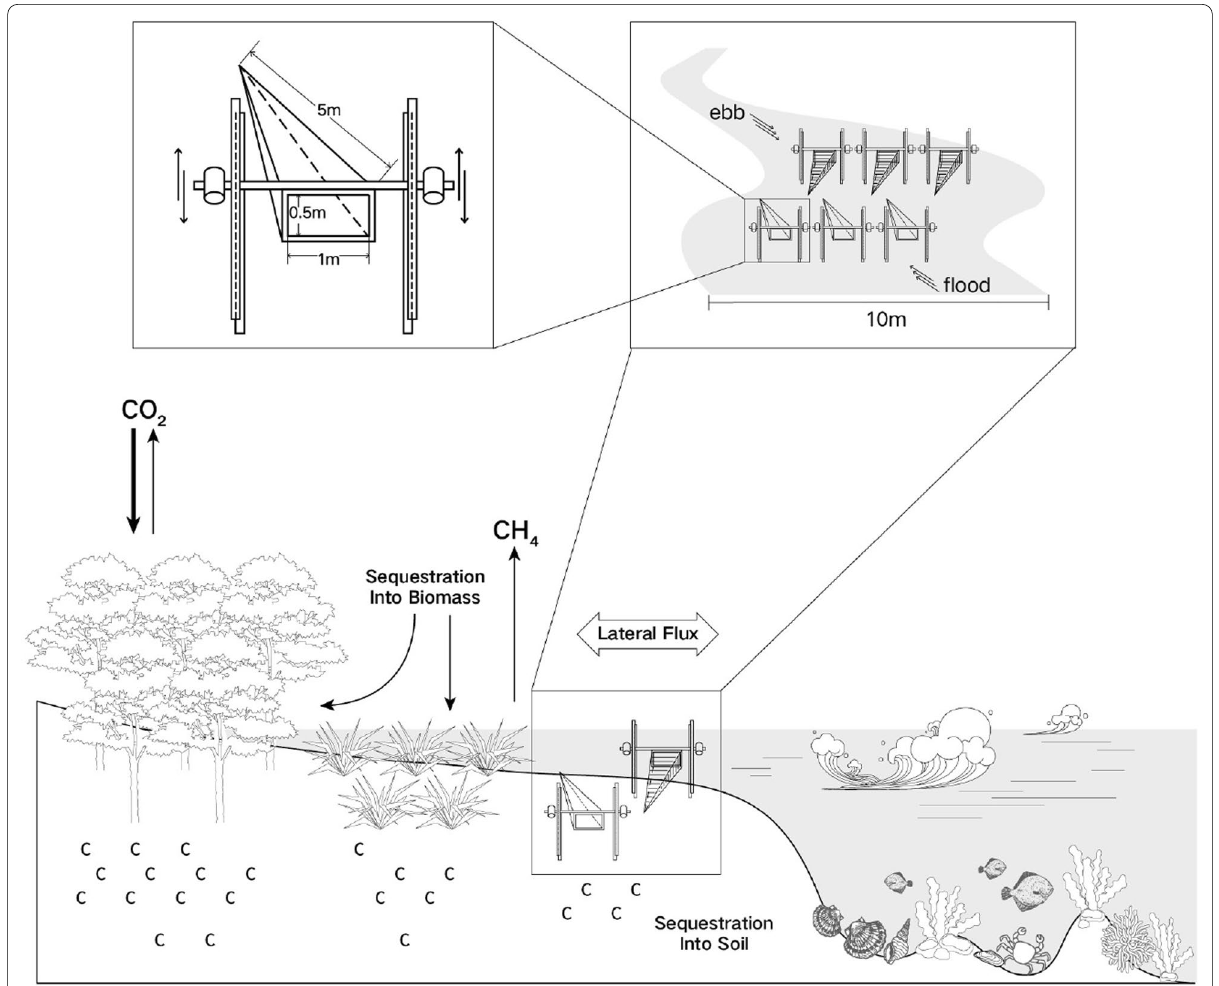
Fig. 2 Schematic diagram showing the design of nets for catching imported and exported detritus in coastal wetlands, the location of the nets, and the layout of the nets. The nets used for exported detritus were only placed during ebbing tides, and the nets used for imported detritus were only placed during flood tides to avoid disturbance. The nets were located in the same cross-sectional position of the creek, and we offset them in the diagram to make them